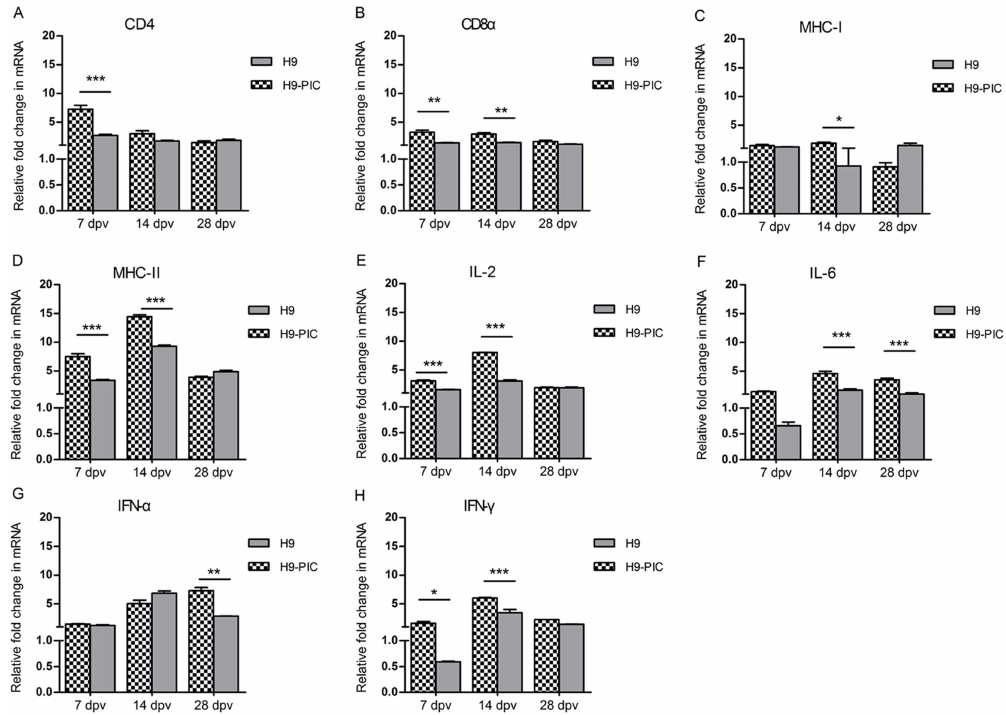
Fig 2. The mRNA expression levels of immune genes in duck spleens. Spleensof ducks immunizedwith H9 vaccine, H9-PIC vaccine and PBS were harvestedfor RNA isolationat 7-, 14-, and 28-day post-vaccination. The mRNA levels for CD4 (A), CD8 α (B), MHC-I (C), MHC-II (D), IL-2 (E), IL-6 (F), IFN- α (G) and IFN- γ (H) were evaluatedby real-time PCR. Expression of target geneswas normalizedto those of duck β -Actin. The relative fold changewas calculatedusing PBS injectedducks as control. Bars indicate mean ± SEM of a representative experiment. ( * P < 0.05, ** P < 0.01, *** P < 0.001). Experimental groupsare as in Table 2.